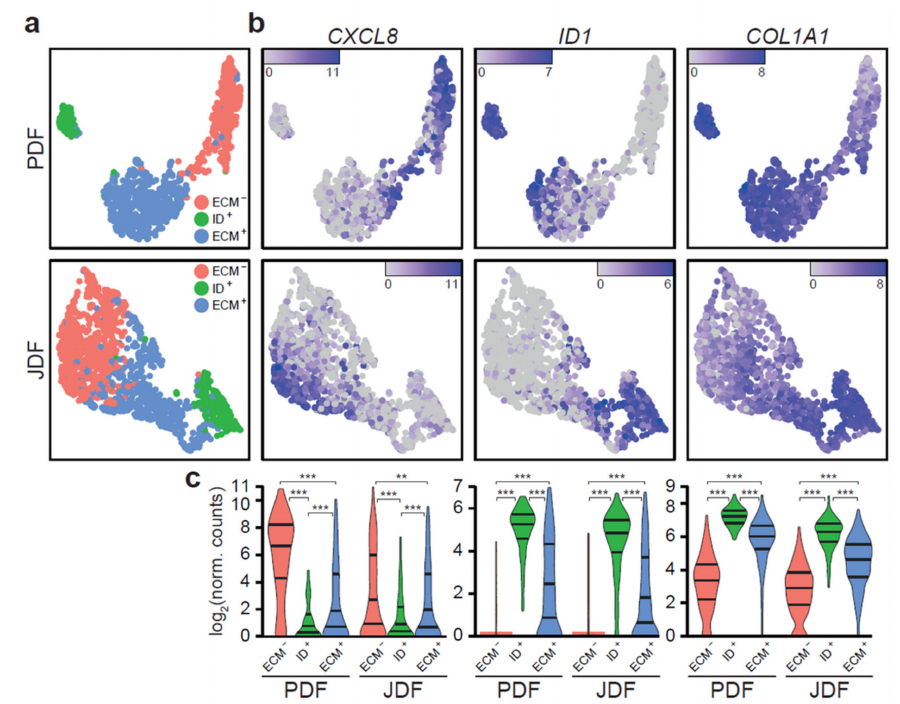
Figure 2. Fibroblasts in JDF and PDF spheroids split into three phenotypically distinct clusters. ( a ) The clusters are defined by specific gene expression signatures and separate well in the UMAP visualisation. ( b ) ECM- cells produce various cytokines and interleukins ( CXCL8 ), ID + cells are identified by strong expression of ID genes ( ID1 ), and ECM + cells by marked expression of ECM components ( COL1A1 ). ( c ) The clusters are equivalent in JDF and PDF spheroids and display statistically significant di ff